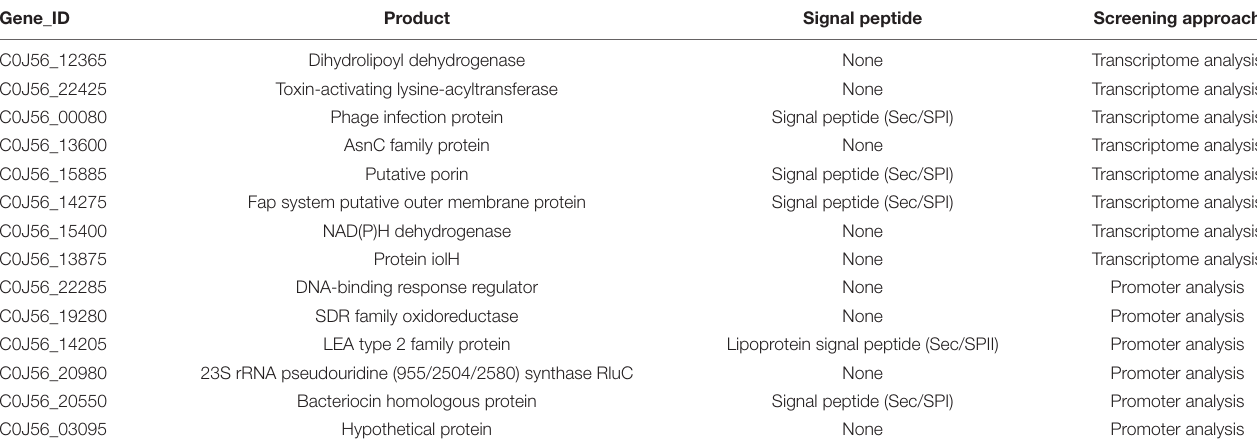
FIGURE 4 | Identification of InvF regulons. (A) Number of up-regulated (red bars) and down-regulated (blue bars) differentially expressed genes (DEGs) from RNA-seq analysis of 2P24 (cid:49) invF compared with strain 2P24 at 6 and 12 h after being incubated in MG medium [Fold change ≥ 1.5; p value ≤ 0.05]. (B) Expression profiles of InvF up-regulated genes selected from RNA-seq DEGs in strains 2P24 and 2P24 (cid:49) invF by qRT-PCR. Graph shows gene expression levels in strains 2P24 or 2P24 (cid:49) invF at 6 or 12 h after being incubated in MG medium, as quantified by qRT-PCR. (C) Expression profiles of InvF up-regulated genes selected from the adjacent downstream genes of predicted InvF binding sites in strains 2P24 and 2P24 (cid:49) invF by qRT-PCR. Graph shows gene expression levels in strains 2P24 or 2P24 (cid:49) invF at 6 h after being incubated in MG medium, as quantified by qRT-PCR. Gene expression was normalized to the expression level of reference gene recA using the 2 − (cid:49)(cid:49) Ct method. Data are means of three replicates. Error bars represent SD. *, **, and *** represent P < 0.05, P < 0.01, and P < 0.001, respectively. TABLE 3 | InvF regulons up-regulated by InvF and the predicted information about signal peptide of each protein